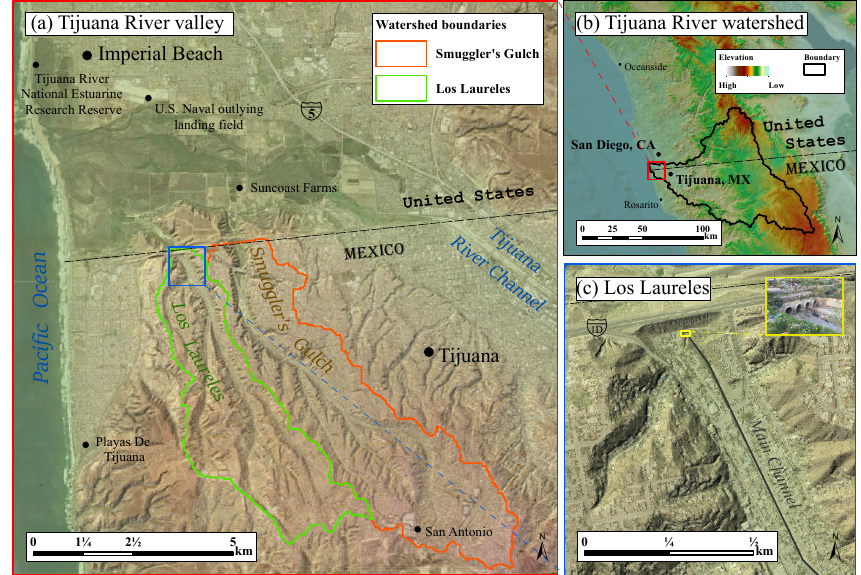
Figure 1. (a) Tijuana River valley and relevant features. The valley is bounded by the city of Imperial Beach to the north, the city of San Diego to the east, and the city of Tijuana to the south. (b) Tijuana River watershed and broader geographical context. Notice the international aspect of the watershed; about one-third of the watershed area is within the US, and the rest is within Mexico. (c) Los Laureles community and Los Laureles main channel. The culvert is also shown, which conveys storm-water discharges from the channelized section of the Los Laureles stream